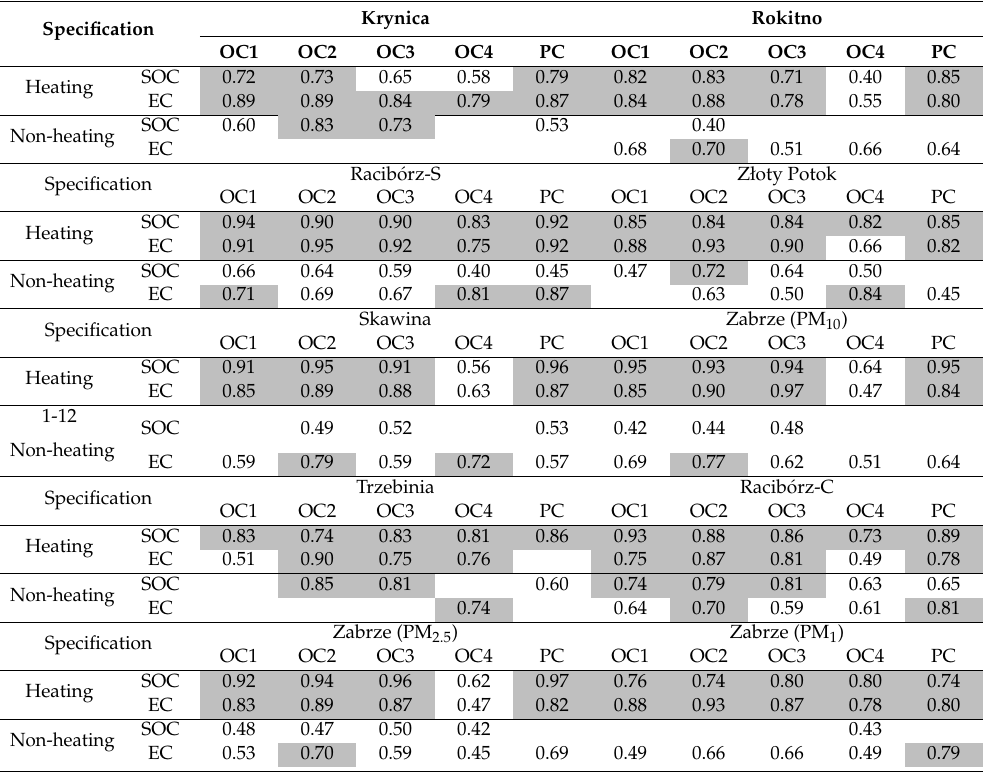
Table 5. Results of nonparametric (Spearman) correlation analysis ( α = 0.05) between concentrations of OC1–4 and PC fractions and concentrations of SOC and